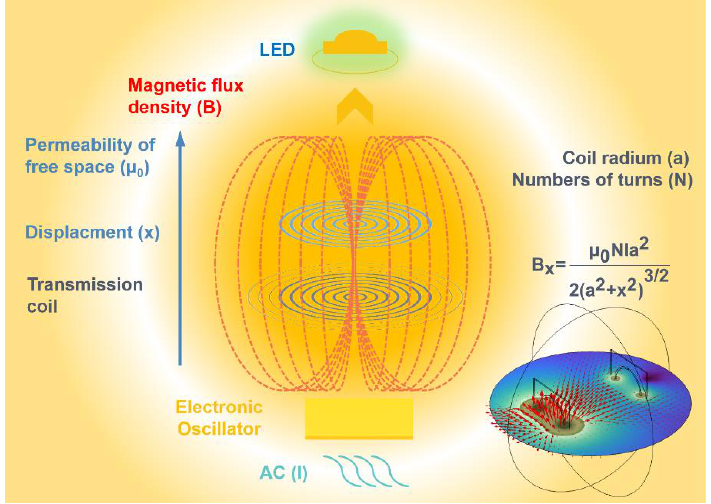
Figure 1. 2D and 3D schematic diagram of a contactless electroluminescent device. The lower right corner is the 3D schematic diagram.